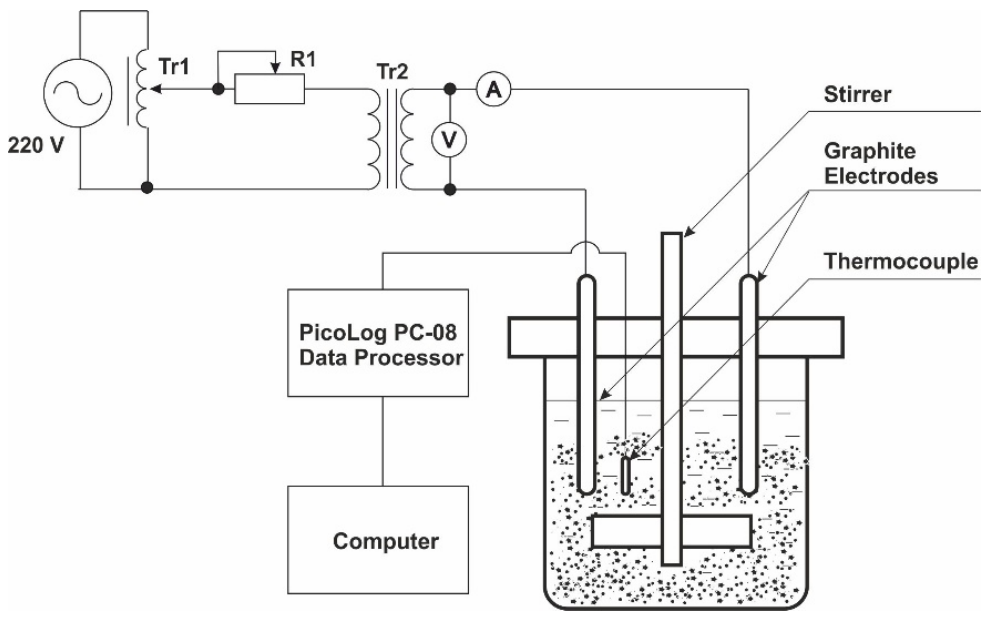
Figure 2. Scheme of the experimental setup: AC circuit (Tr1—laboratory autotransformer, R1—rheostat, Tr2—step-down transformer, V—AC voltmeter, A—AC ammeter) and electrochemical cell.